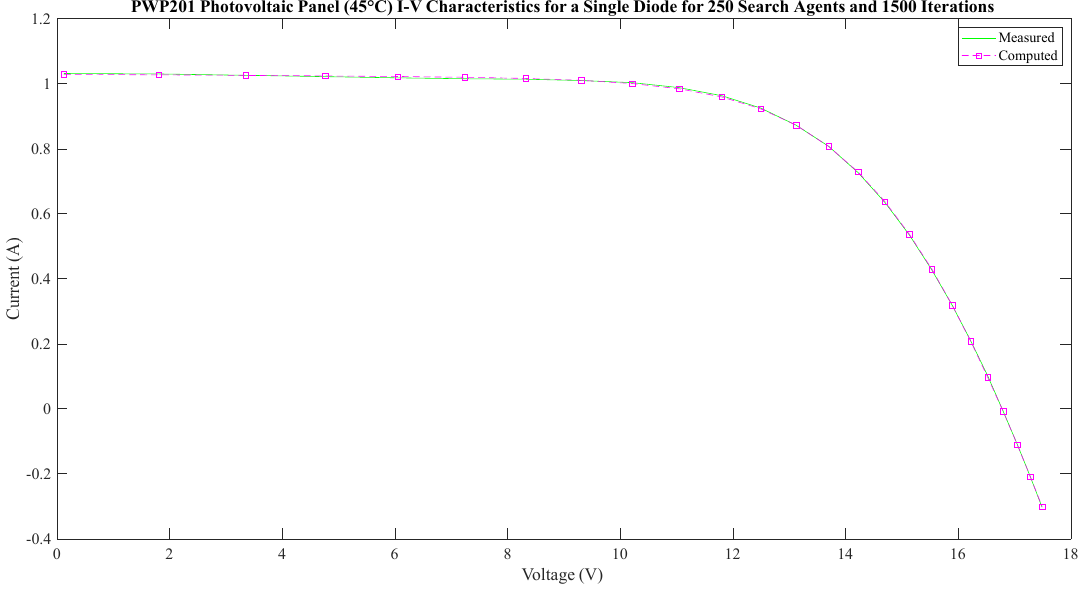
Figure 7. The current-voltage characteristics of PWP201 photovoltaic panel for a single diode (SDM).